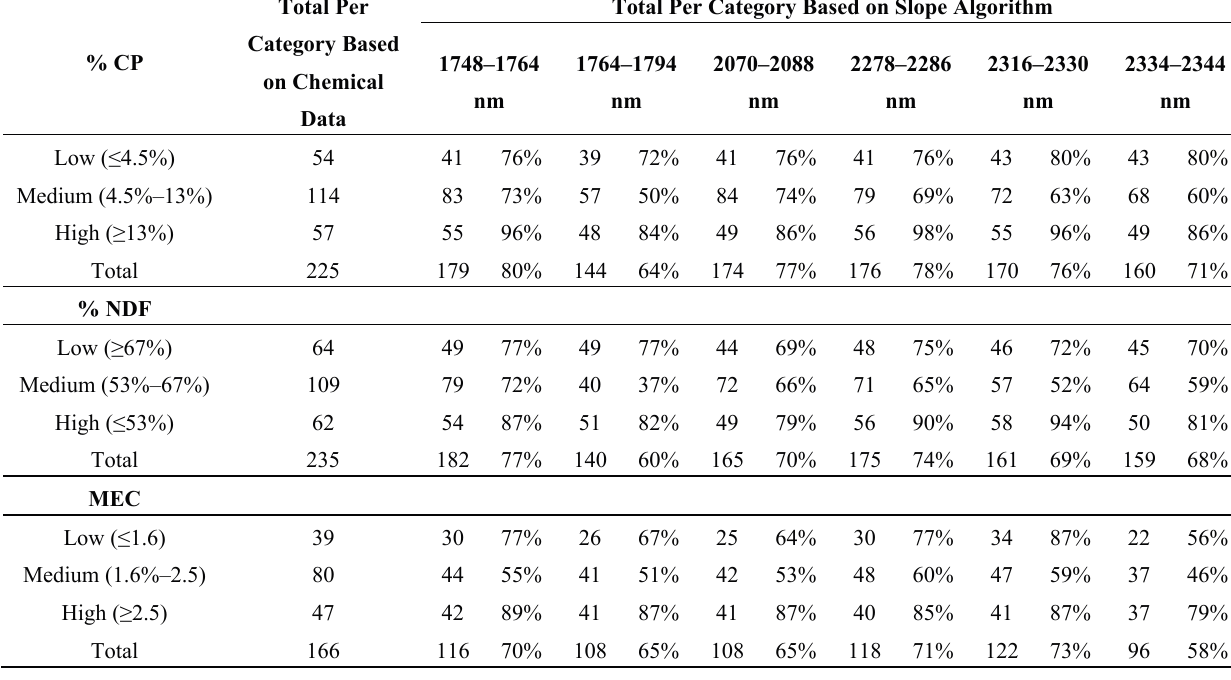
Table 2. Success rates of pasture-quality evaluations using slope algorithm. Note that chemical data were used as